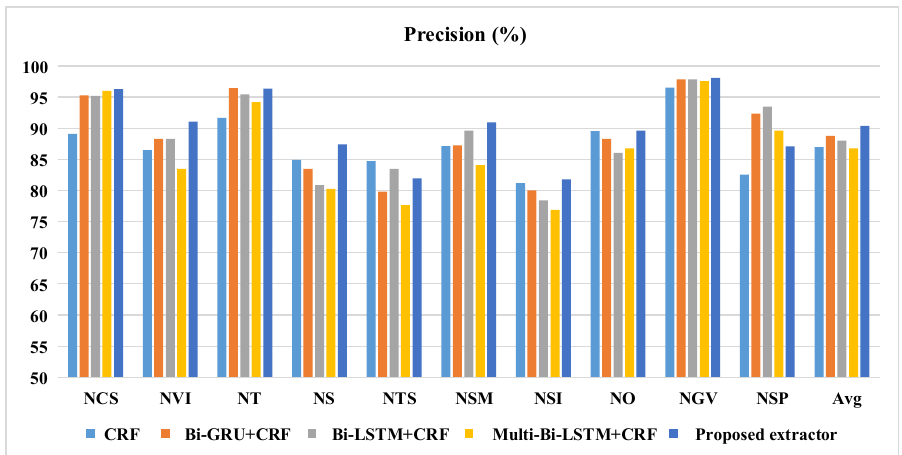
Figure 6. Precision performance of the deep learning-driven extractor and baselines in each category.